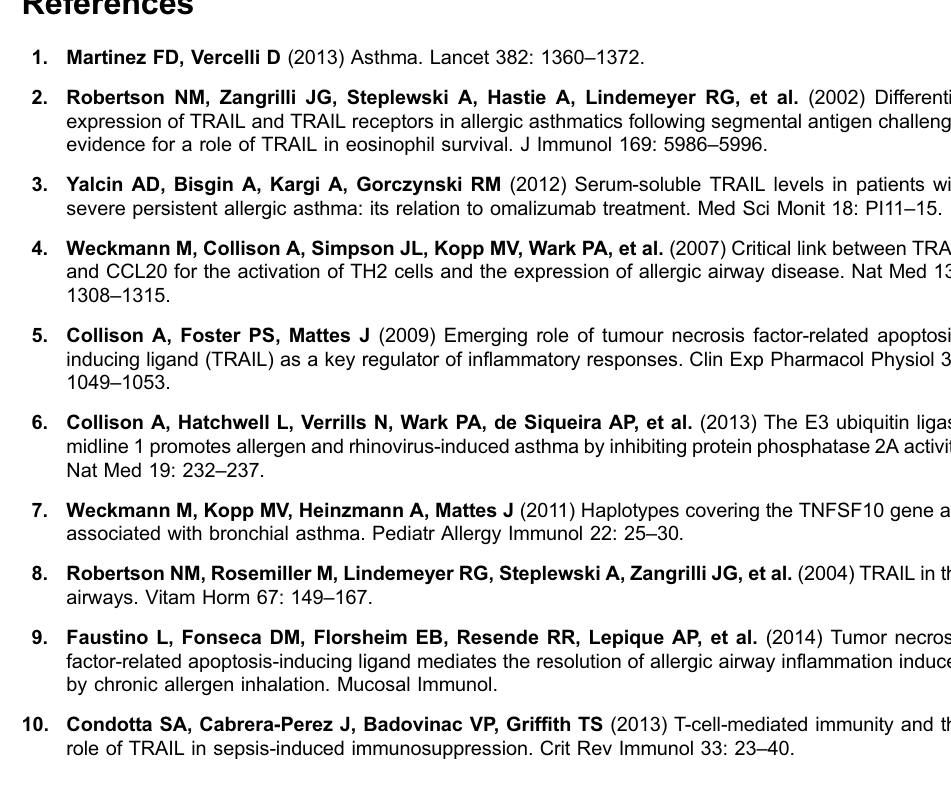
S1 Table. Levels of cytokines and growth factors analysed by multiplex